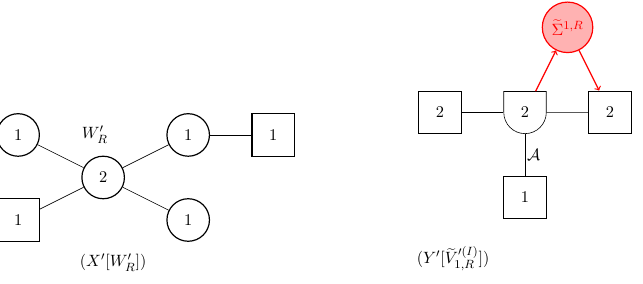
Figure 45 . Wilson defect in a flavored D 4 quiver, and its dual vortex defect in a U(2) gauge theory.